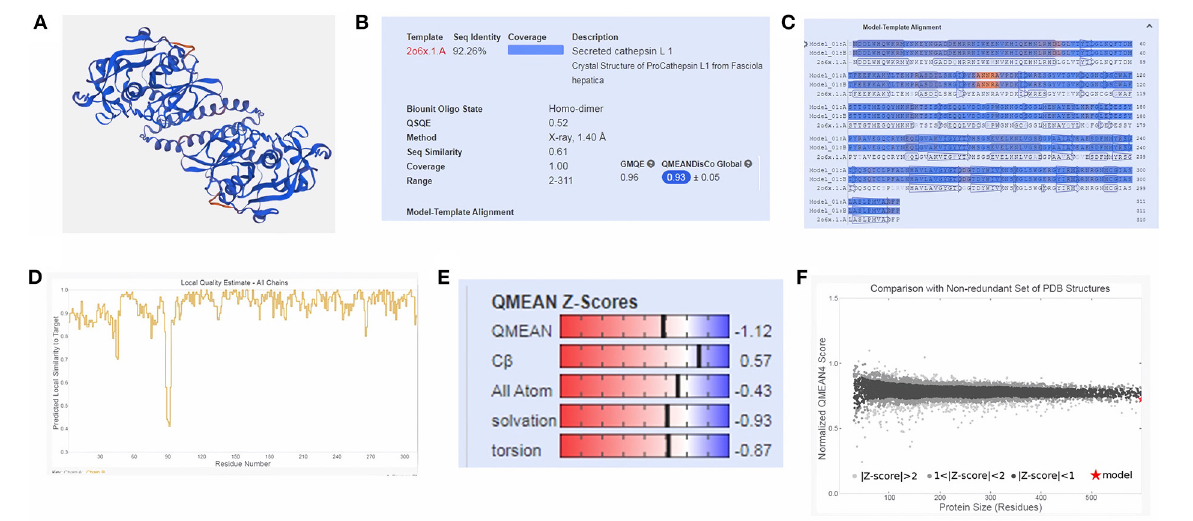
FIGURE2 Tertiary structure of FhCatL1 using SWISS-MODEL server. SWISS-MODEL server results of (A) Computed three-dimensional model; (B) Sequence identity and coverage data; (C) Model-template alignment; (D) Local quality estimate; (E) Global quality estimate; (F) Comparison with non-redundant set of PDB structures